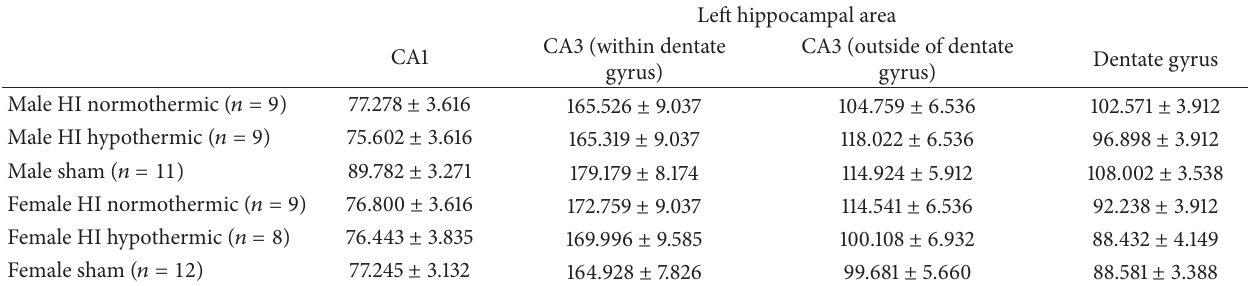
Table 3: Mean and standard error (SE) for subregions of the left